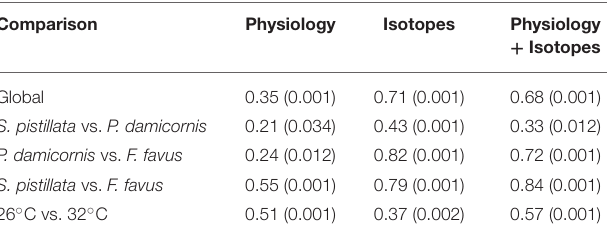
TABLE 5 | Two-way ANOSIMs of physiological, isotopic, and both physiological and isotopic variables combined where species ( S. pistillata, P. damicornis, F. favus ) and treatment (26 ◦ C, 32 ◦ C) were the